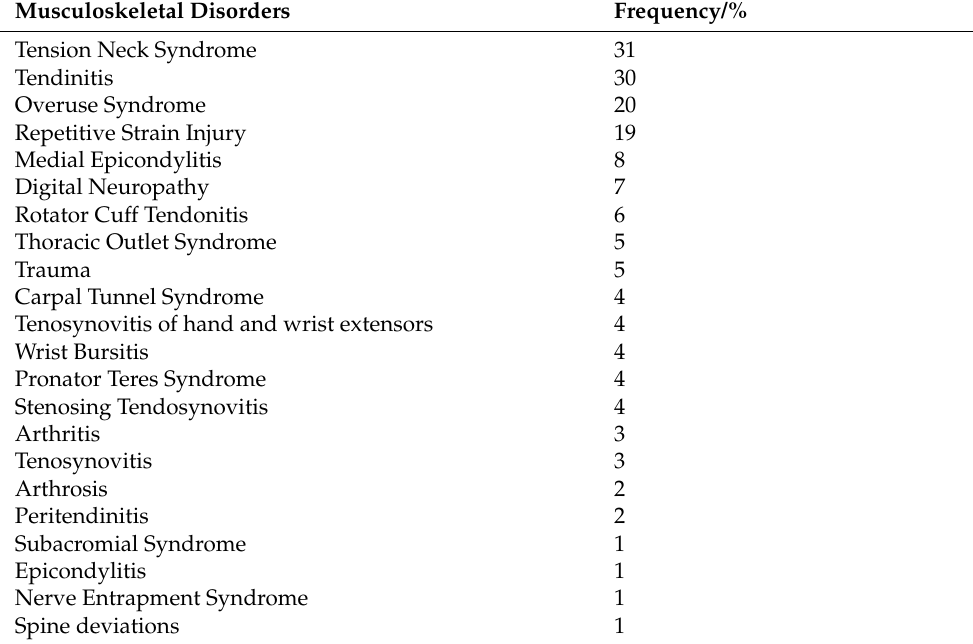
Table 2. Frequency of musculoskeletal disorders and diseases in sign language interpreting and interpreting/guiding ( n =